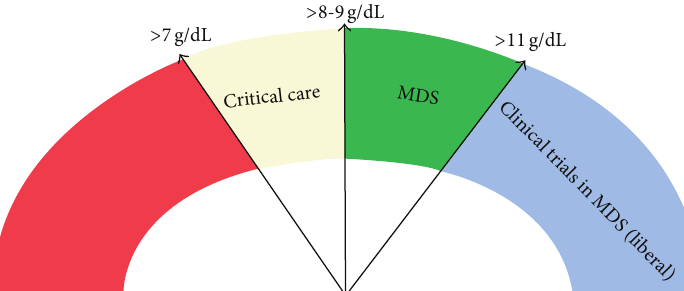
Figure 1: Transfusion thresholds. As a general rule in critical care a restrictive approach would be to transfuse red cells when Hb < 7 g/dL, whereasinmyelodysplasiaandlikelyotherbonemarrowfailuresyndromesmorepractitionerswouldtransfusewhenHbis < 8-9